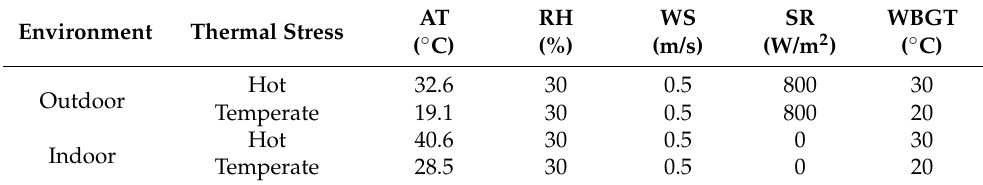
Table A4. Simulated environmental conditions during lab experiments.